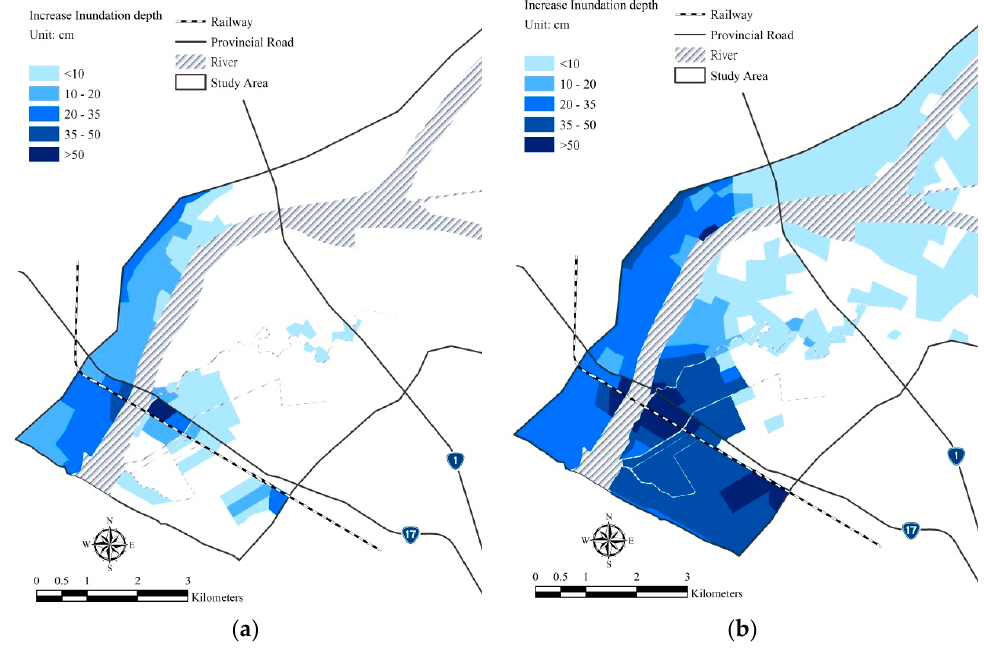
Figure 8. ( a ) Spatial distribution of inundation depth increase after land subsidence for a one-day storm under a 50-year return period; ( b ) Spatial distribution of inundation depth increase after land subsidence combined with climate change for a one-day storm under a 5-year return period.